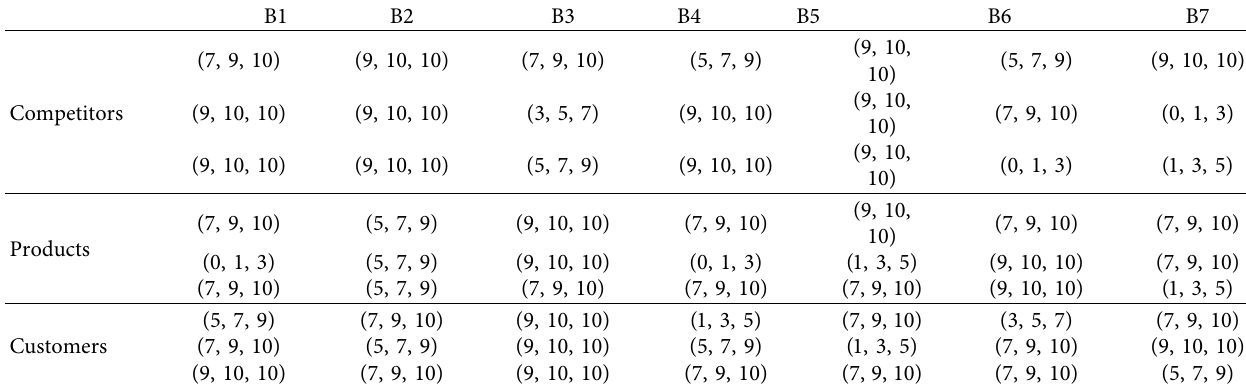
Table 10: About each criterion, DMs’ judgments of the corporate social responsibility factor depending on competitive supply chain pricing in oil companies.